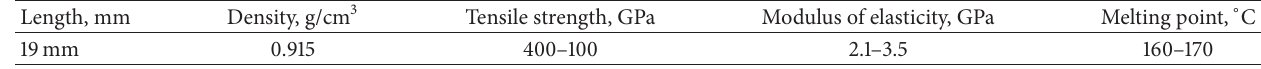
Table 2: Properties of polypropylene fibres.